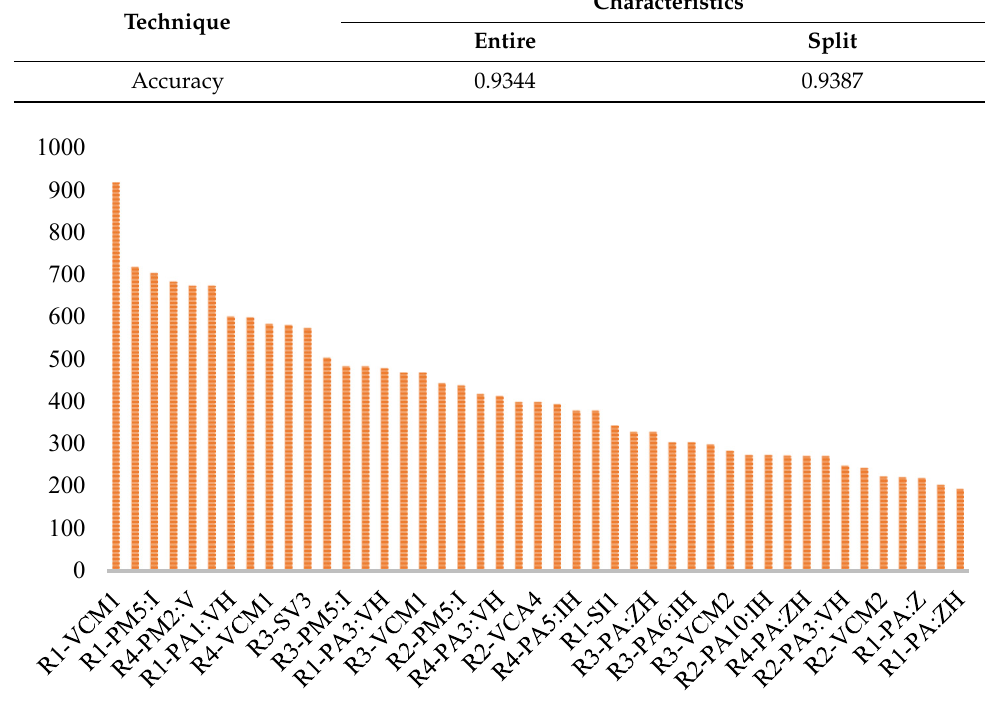
Figure 4. Significance features score.